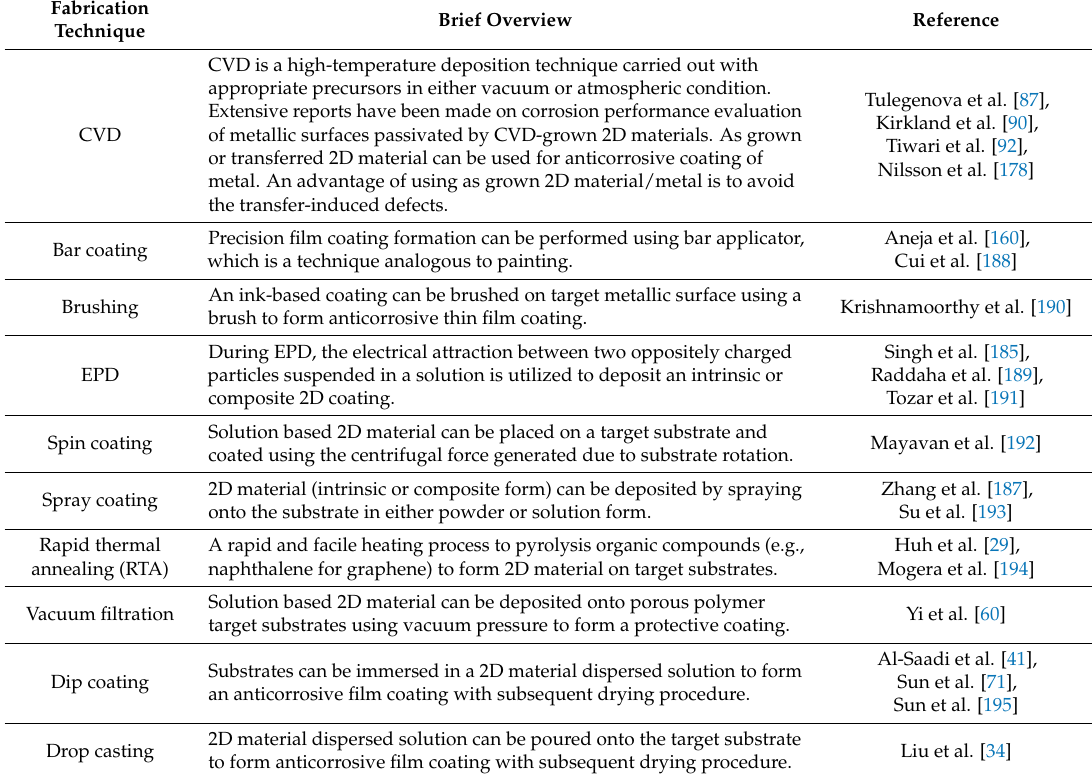
Table 5. A brief overview of various fabrication techniques of 2D coating on a target